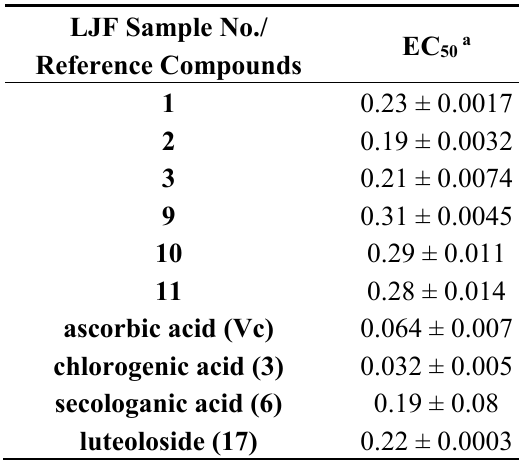
Table 3. The EC 50 values of sulfur-fumigated LJF, sun-dried LJF and reference